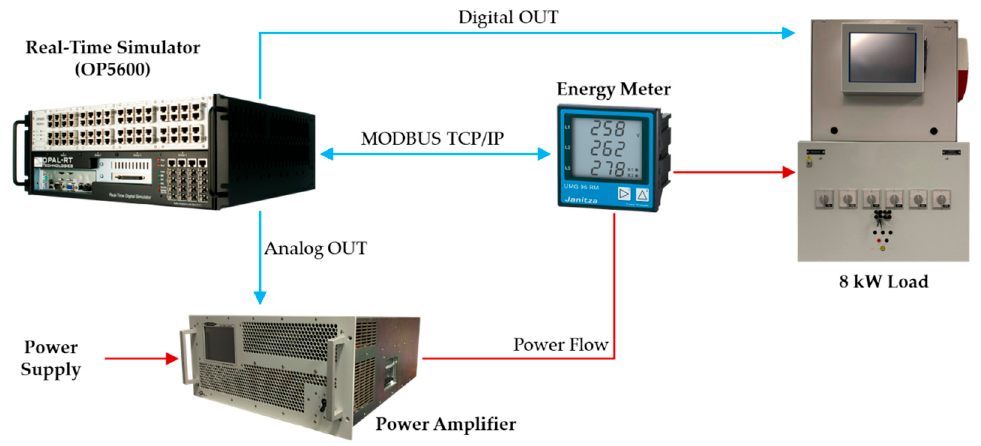
Figure 11. Implemented power hardware in the loop (PHIL) methodology using OP5600 and power amplifier.